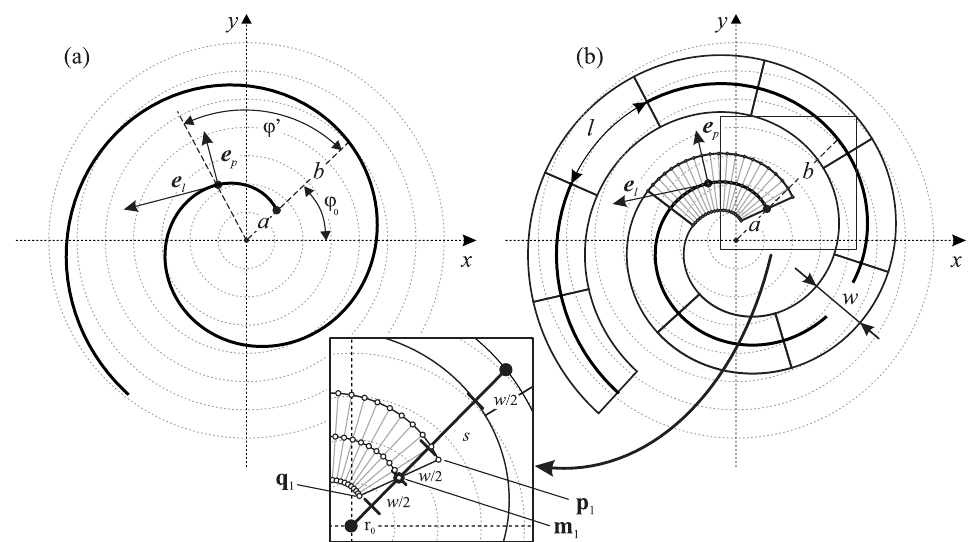
Figure 1. Design of the spiral strip graphic. ( a ) Spiral curve (thick line) defined by Equations (2) and (3) shown in a Cartesian coordinate system denoted by the x and y axes. Dashed circles represent the distance to the center of the coordinate system. ( b ) Similar to ( a ), but with individual segments shown along the spiral. The segment’s width is denoted by w and the length by l . The inset area in the middle shows a more detailed view of the region denoted by the